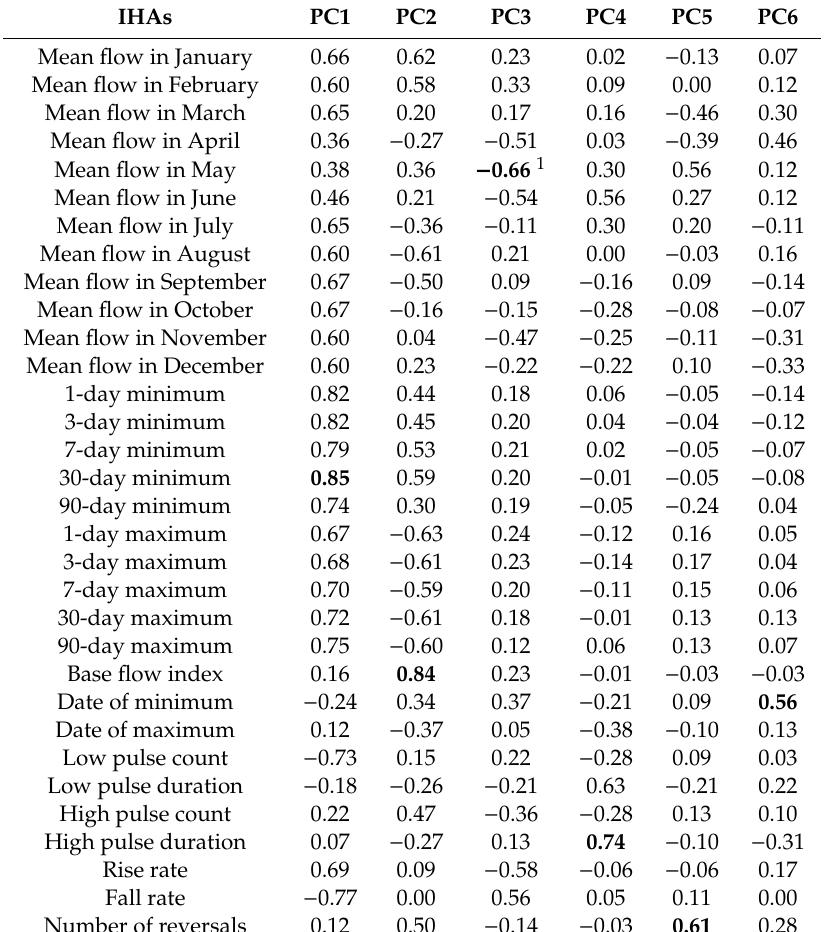
Table 5. Six principal components (PC) are selected, which are the 30-day minimum, BFI, mean flow in May, high pulse duration, number of reversals, and date of minimum. The selected six ERHIs are distributed in five IHA groups (Table 2); therefore, the ERHIs can reflect the five characteristics of hydrological regime and are poorly related to each other. The results are similar to previous research results [10,23,26]. Table 5. ERHI results using the principal component analysis